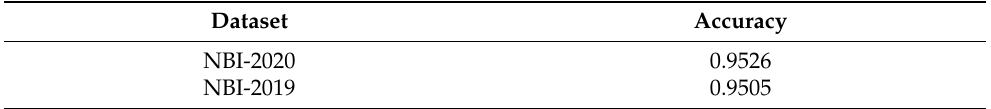
Table 13. XGBoost model performance on the new